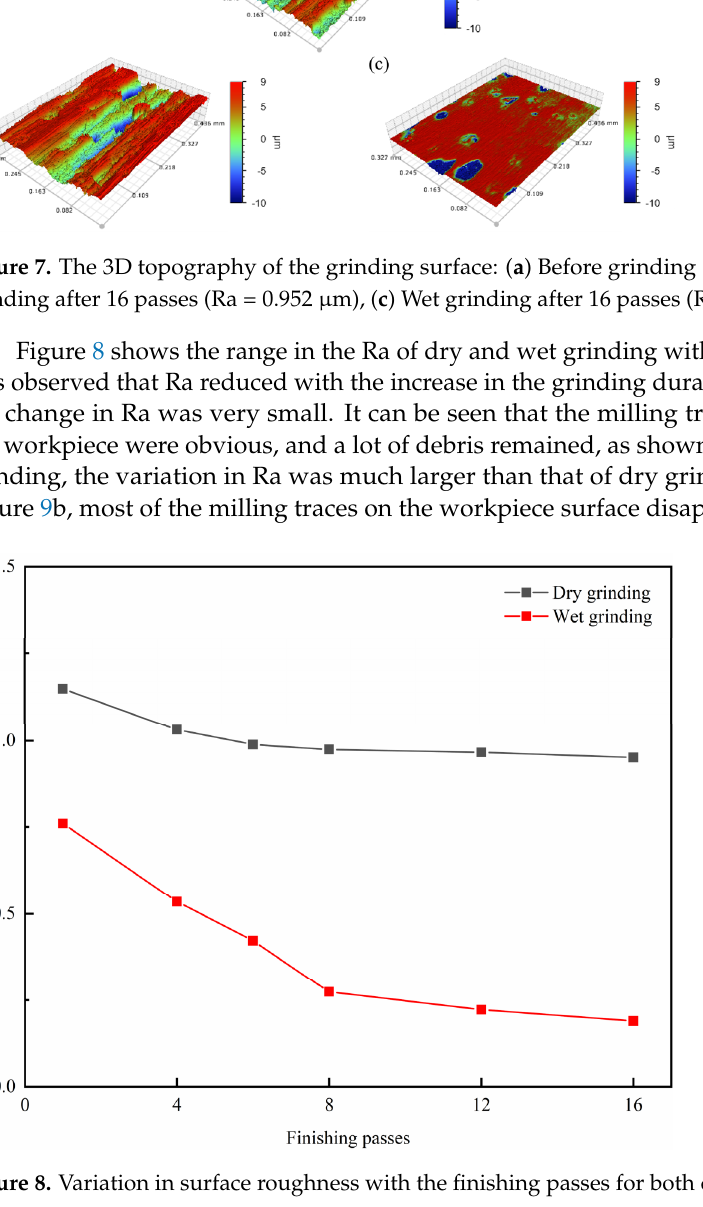
Figure 9. The optical image of the grinding surface (200×): ( a ) Workpiece surface after dry grinding, ( b ) Workpiece surface after wet grinding. To sum up, the use of cutting fluid can obviously improve the grinding quality. Using this method, an Ra 0.19 μm was realized in 128 min. 3.4. Grinding Temperature According to Figure 6, the experimental parameters corresponding to the maximum material removal rate (grain size 20 μm, spindle speed 900 rpm, feed rate 20 mm/min, and tool compression 0.4 mm) were selected, the grinding experiment was conducted, and then the grinding temperature was measured. An infrared thermometer and a digital explicit K-type thermocouple were used for comparative measurement during grinding. In the grinding experiment, the infrared thermal imager did not capture the obvious temperature difference of the grinding